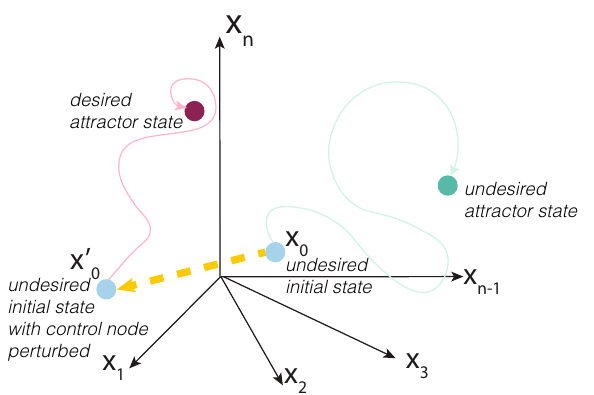
Fig. 1 Control theory view of cell fate reprogramming. The feedback vertex set control is a structure-based control method that can be applied to cell-fate reprogramming. By performing appro- priate concerted perturbations to the minimal Feedback Vertex set on an initial state of the system that leads to an undesired attractor (green circle), the system can be shifted (yellow dashed lines) to a trajectory that leads to a desired attractor (magenta